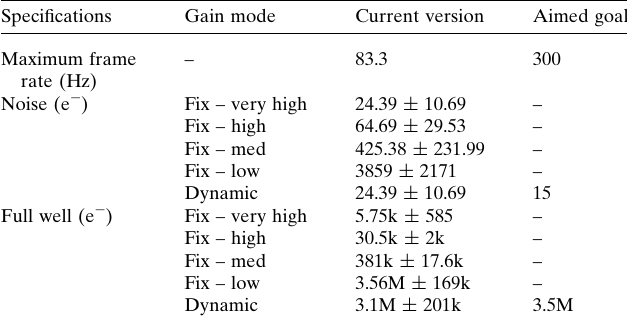
Table 1 PERCIVAL current status versus aimed